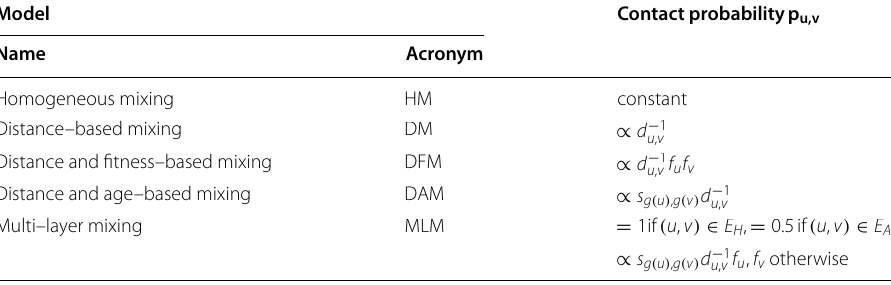
p u , v is the probability that u and v are connected at each step of the simulation f u is the Lognormally distributed social fitness of u s g u , g v is the data–driven age–based social mixing for u and v ’s age groups E H and E A are the edge sets of two static networks, respectively used to represent households and acquaintances (see Sect. 4 and Guarino et al. (2021) for more details)